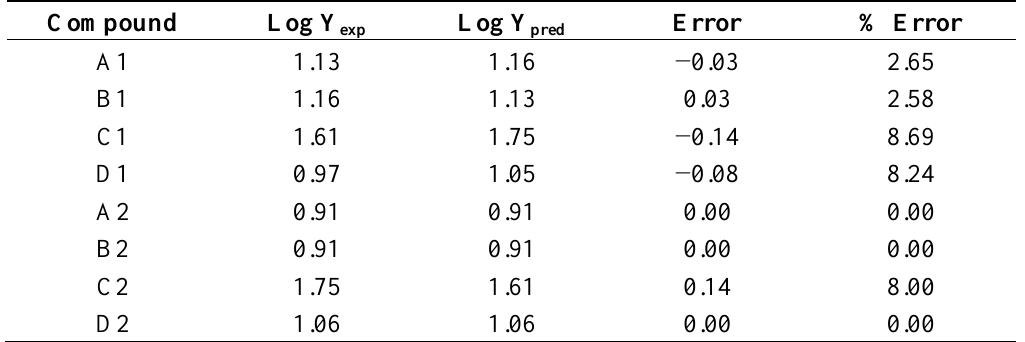
Table 3. log Y and log Y antiradical activity, error and % error values of coumarin exp pred